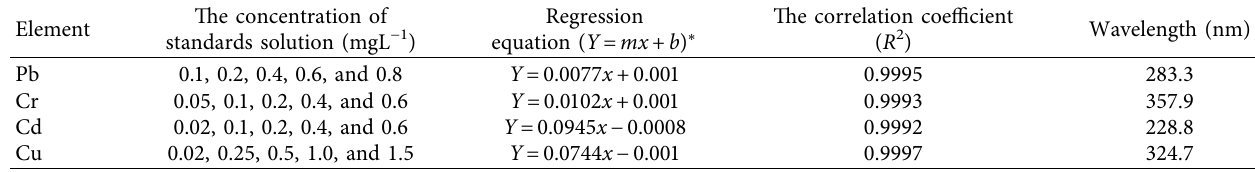
Table 3: Linear regression equations and the coefcient of determination ( R 2 ) of each heavy metal in the study area. Element